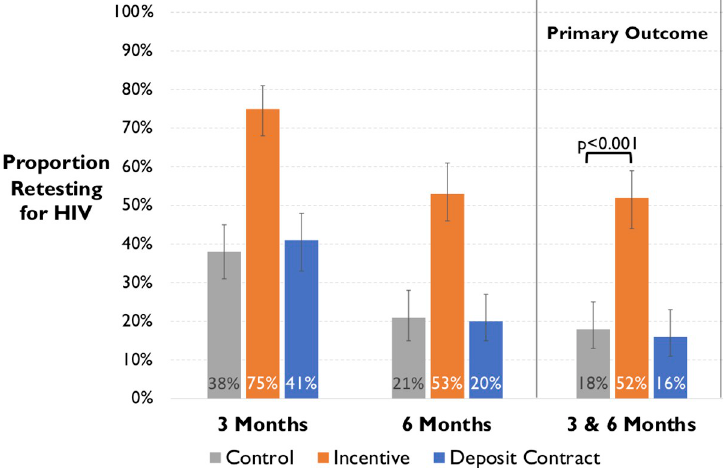
Fig 3. The proportion of participants (with 95% confidence intervals) retesting for HIV at both 3- and 6-month post-randomization (primary outcome) and at the 3-month or 6-month time points, by study group in a randomized trial of financial incentives and deposit contracts vs control, to promote HIV retesting.